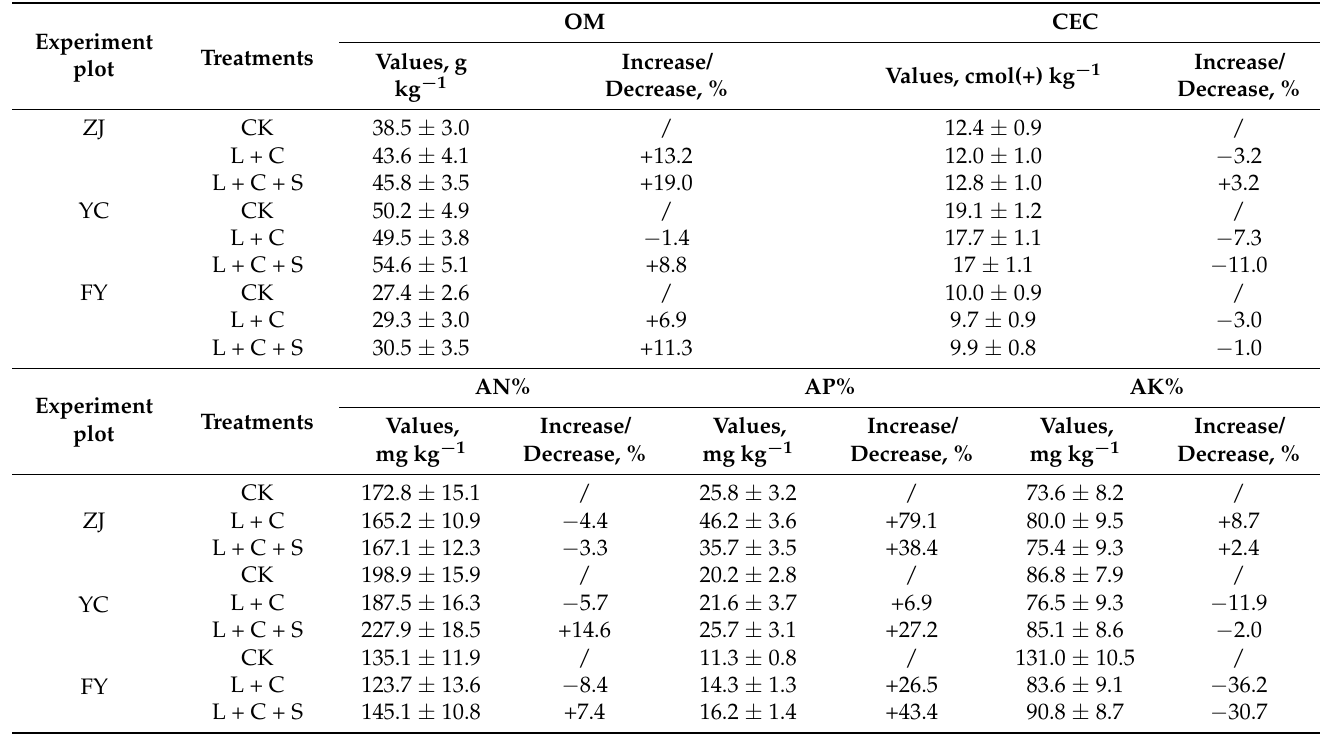
Table 3. Physicochemical properties of paddy